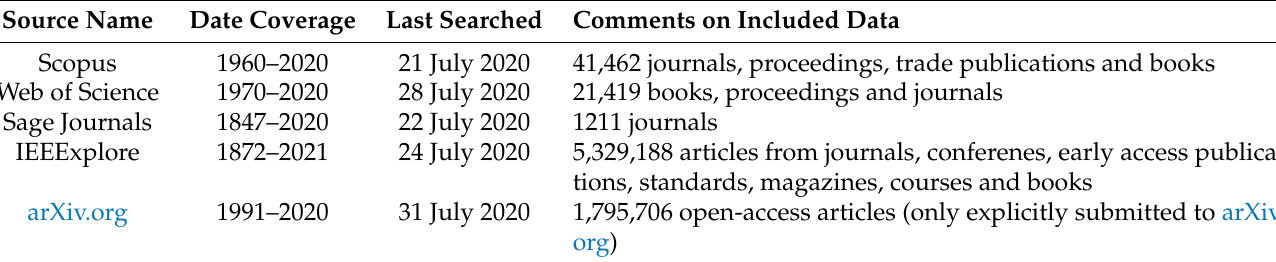
Table 1. Overview of information